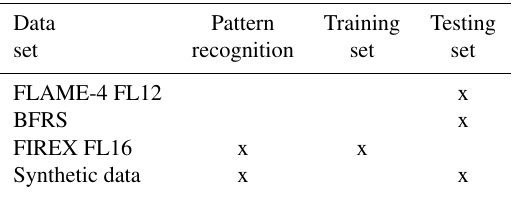
Table 2. Data sets used for developing the pattern recognition algo- rithm and the testing and training classification